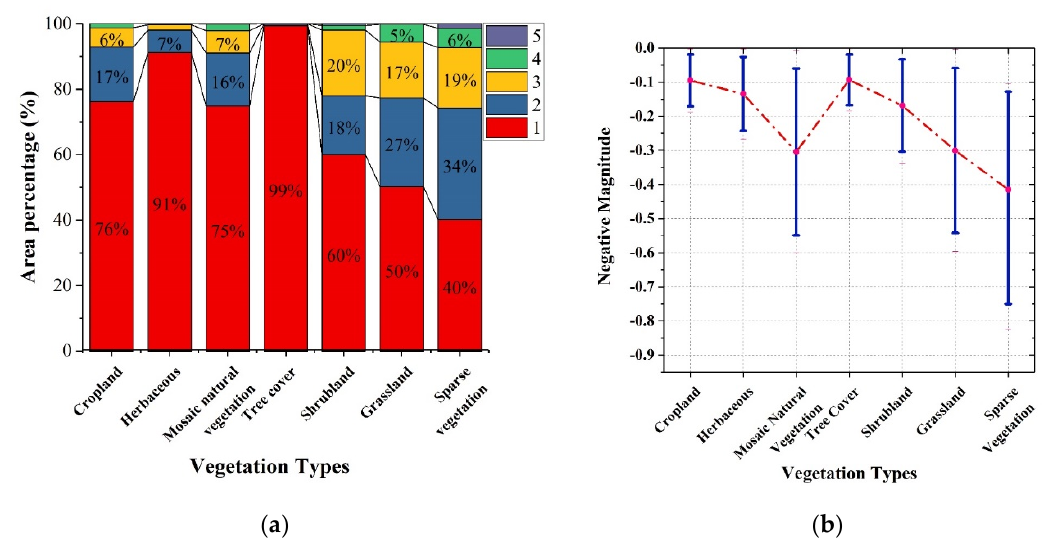
Figure 8. ( a ) Area percentage of the number of negative changes in different vegetation types between 2000 and 2018. ( b ) Interval plot of the negative magnitude for different vegetation types (the blue line indicates the range of the 95% confidence intervals, and the red dot in the center is the mean value).